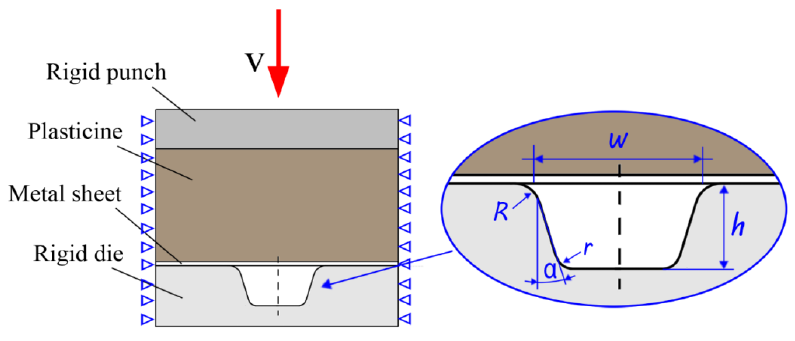
Figure 9. The sketch of the shape and geometric dimensions of the model.